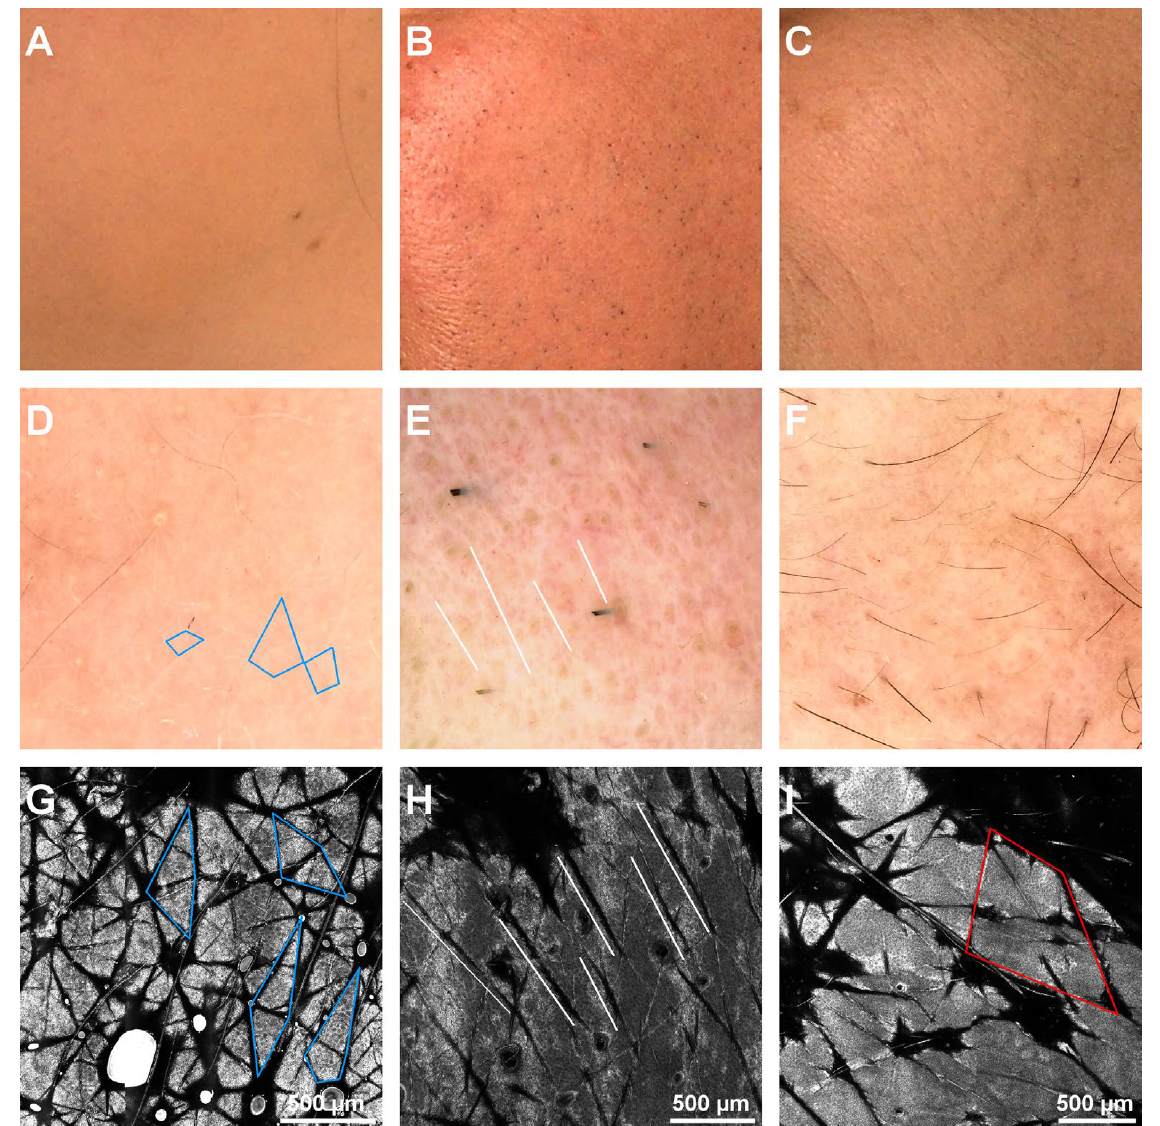
Figure 3. Clinical, dermoscopy, and confocal microscopy (RCM) images of different furrow patterns. ( A ). Clinical image of the left cheek of a 36-year-old female. ( B ). Clinical image of the left cheek of a 57-year-old male. ( C ). Clinical image of the left cheek of a 68-year-old female. ( D ). Dermoscopy image of the patient in panel A showing a small rhomboidal furrow pattern (blue rhombi). ( E ). Dermoscopy image of the patient in panel B showing a parallel rhomboidal furrow pattern (white lines parallel with furrows). ( F ). Dermoscopy image of the patient in panel C. ( G ). RCM mosaic showing the small rhomboidal furrow pattern (blue rhombi) in the 36-year-old female. ( H ). RCM mosaic revealing the parallel rhomboidal furrow pattern (white lines parallel with furrows) in the 57-year-old male. ( I ). RCM mosaic displaying large rhomboidal furrow pattern (red rhombus) in the 68-year-old female. Regarding the honeycomb pattern, it was observed that the percentage of irregular honeycomb patterns increased with age. Still, it wasn’t statistically significant with a p = 0.079 and H (4) = 8.8 (Kruskal–Wallis test). Figure 4 illustrates the RCM images of different honeycomb